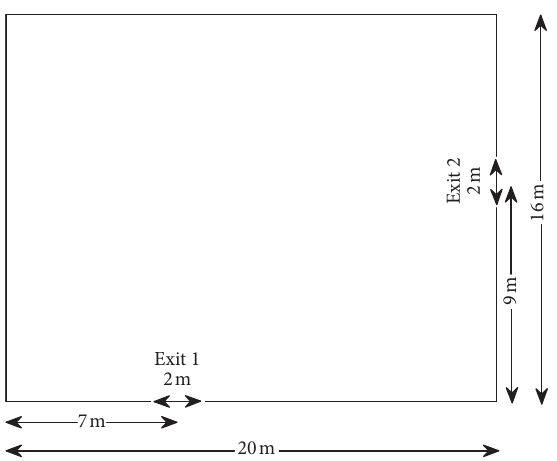
Figure 1: The modeling area for the numerical experiments.